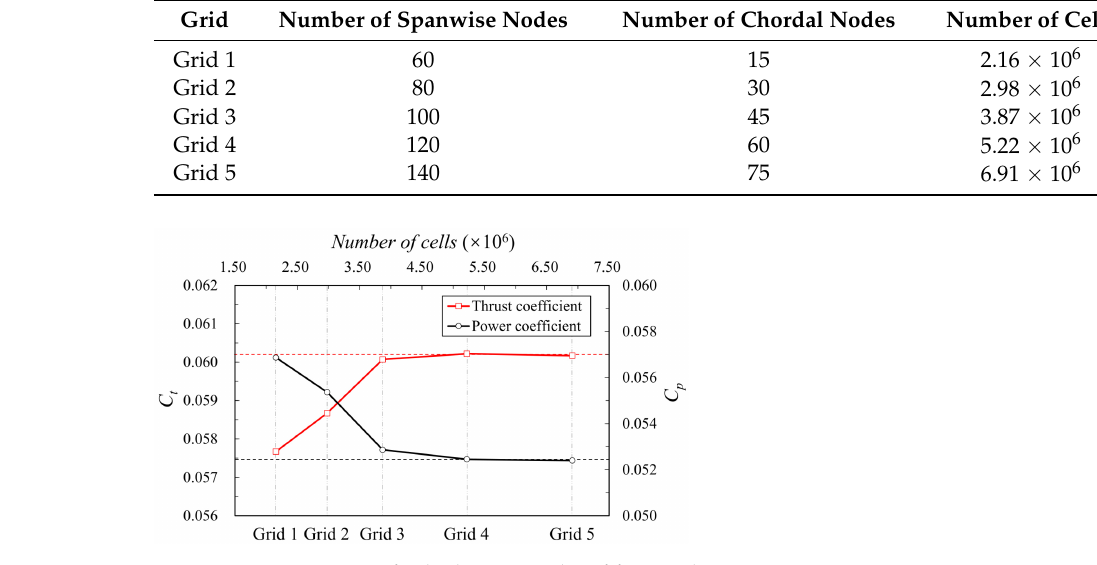
Figure 7. Comparison of calculation results of five grids.